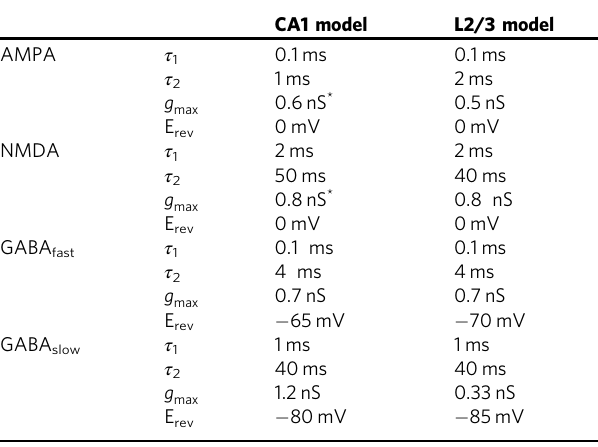
Table 2 Synaptic parameters used in the